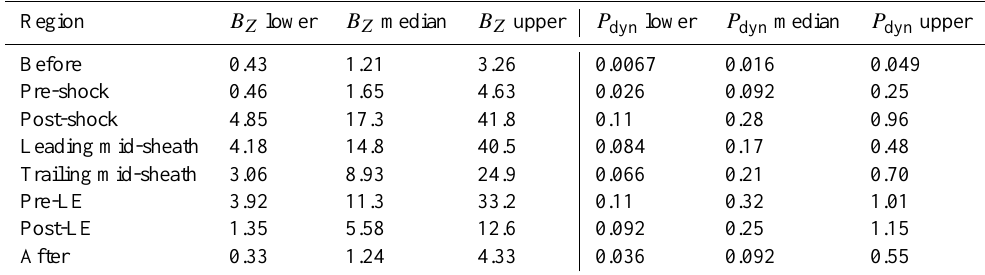
Table 3. The averages of the lower quartile, median, and upper quartile B Z and P dyn ULF powers in different regions (see Fig. 1). Note that we have separated here the mid-sheath into the leading and trailing sections. The units are (nT 2 Hz − 1 ) and (nPa 2 Hz − 1 ) for the B Z and P dyn ULF powers,